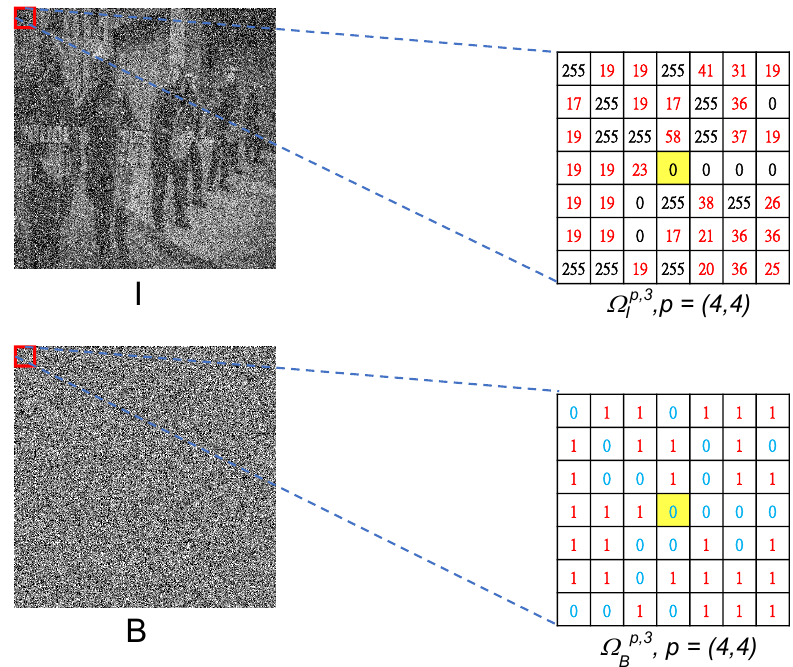
Figure 2. An example of square windows centered at a pixel coordinate p in a noisy image I and the corresponding non-noisy map B , denoted as Ω p , r